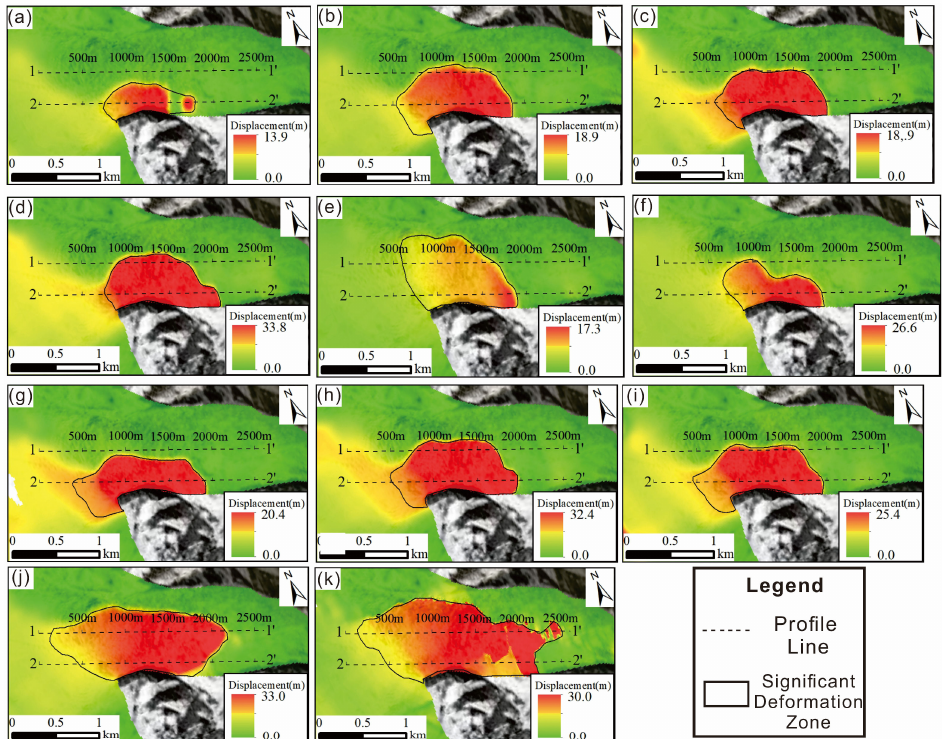
Figure 9. POT deformation results of Sentinel-1 SAR images of different periods. The base map is a Planet satellite image taken on 29 July 2022, and subgraphs ( a – k ) represent periods I–XI, respectively.